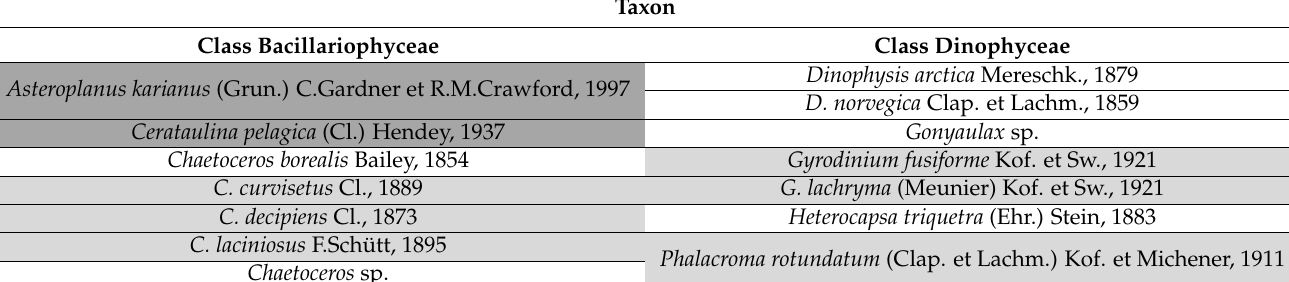
Table 1. Taxonomic inventory of phytoplankton in the seawater regions under consideration: on a light gray background—species found only in the SWKS; on dark gray—only in SEBS; on white—in both